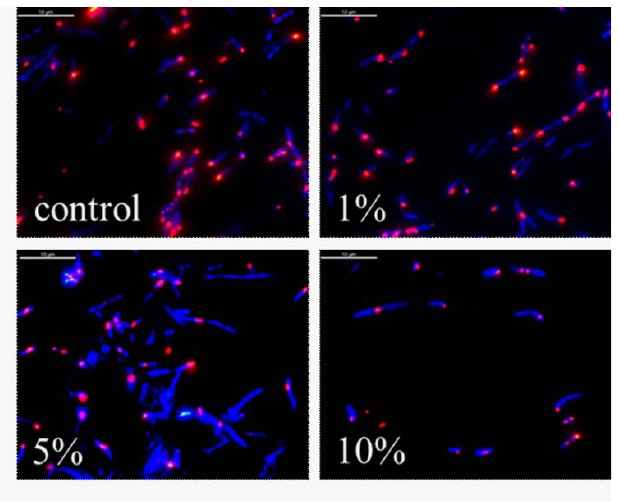
Figure 9. Fluorescence images of E. coli after 6 h incubation with peptide fraction with MW below 10 kDa (red—live cells; blue—dead cells). The marker corresponds to 10 µm. 10 kDa (red—live cells; blue—dead cells). The marker corresponds to 10 µ